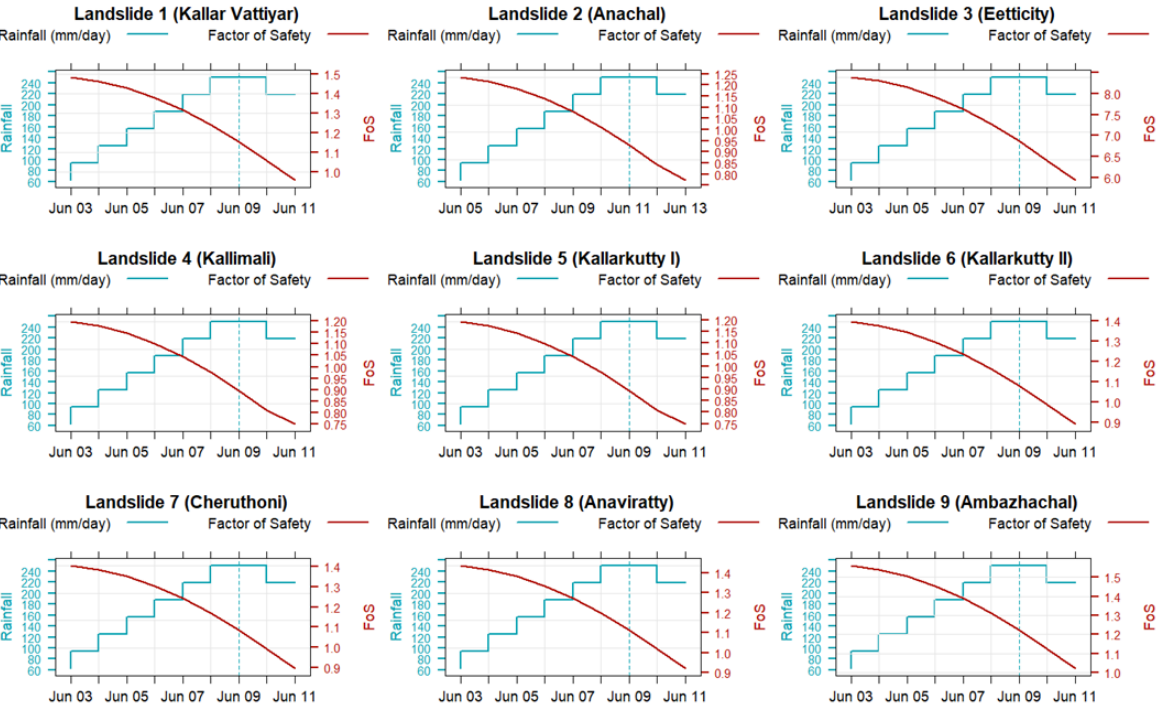
Figure 13. Fall in FoS with respect to nine-day rainfall period at the landslide sites. The vertical dotted line shows the day on which the landslide occurred.